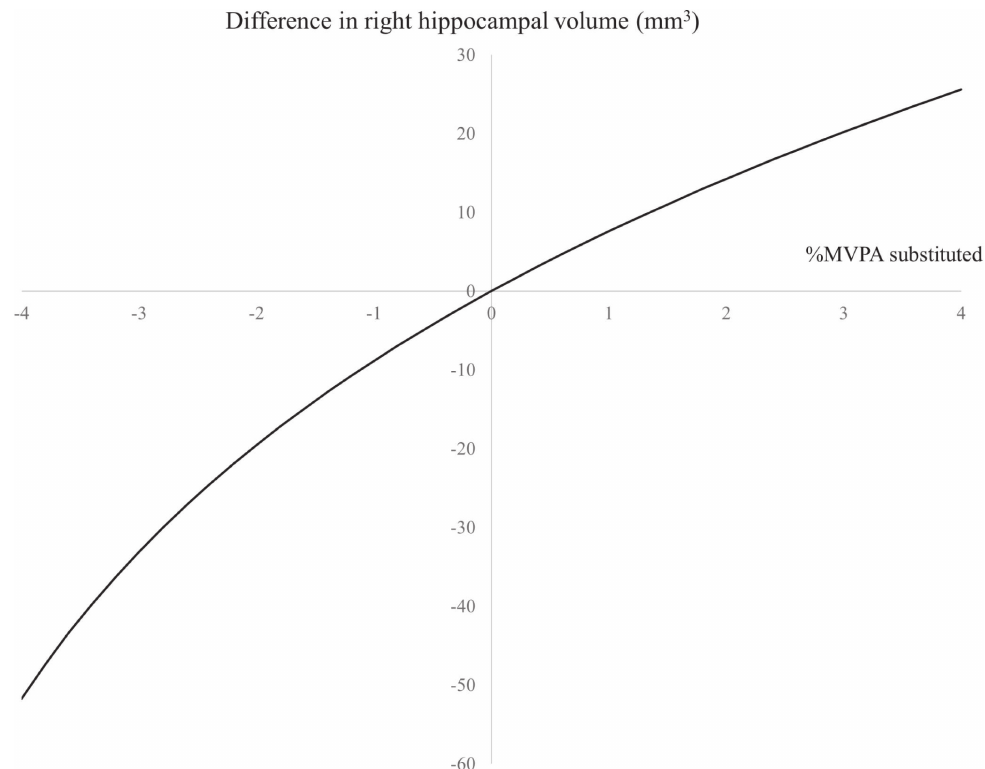
Figure 1. Di ff erence in right hippocampal volume with reallocation of MVPA Analyses were adjusted for sex, age, intracranial volume, education, body mass index, smoking status, alcohol use, and medication for hypertension, dyslipidemia, and diabetes. The reallocation of MVPA expended the remaining activities equally. Mean composition (% / day): sedentary behaviors = 50.5%, light-intensity physical activity = 44.9%, moderate-to-vigorous physical activity = 4.6%. MVPA, moderate-to-vigorous physical